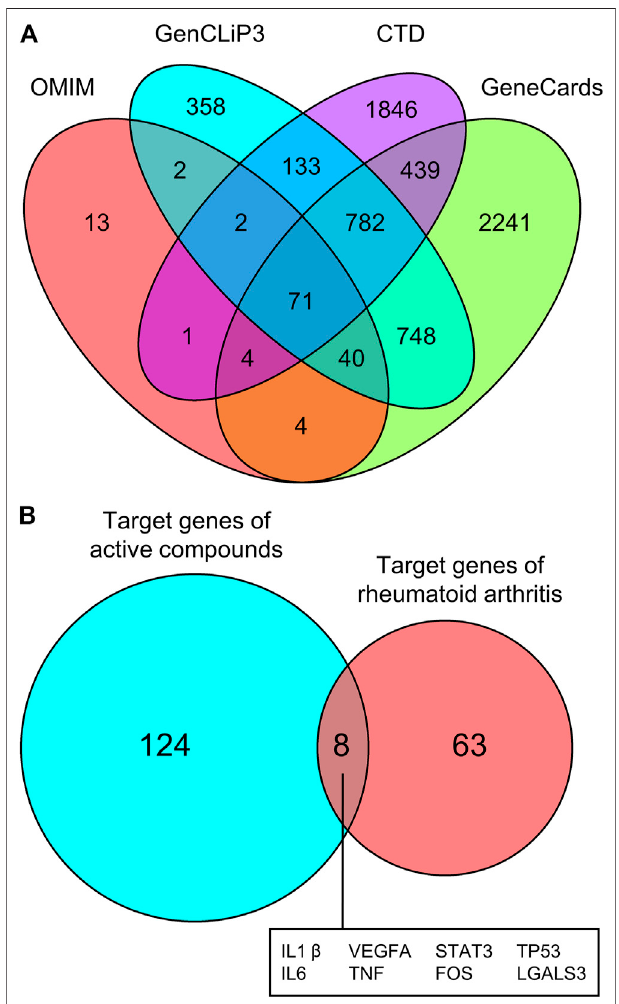
FIGURE 6 | Common targets of RA and active compounds of Cornus of fi cinalis and Paeonia lacti fl ora. (A) The gene targets of RA were screened using four databases (OMIM, GenCLip3, CTD, and GeneCards) and common targetsbetweendatabasesareillustrated using aVenndiagram. Among all identi fi ed targets, 71 were common between all four databases. (B) The 71 targets of RA were compared with the 132 previously identi fi ed targets of Cornusof fi cinalis(loganin,morroniside,andursolicacid)andPaeonialacti fl ora (paeoni fl orin and albi fl orin) and a Venn diagram was generated to illustrate the number of common targets. Between RA and the active compounds, 8 common targets were identi fi